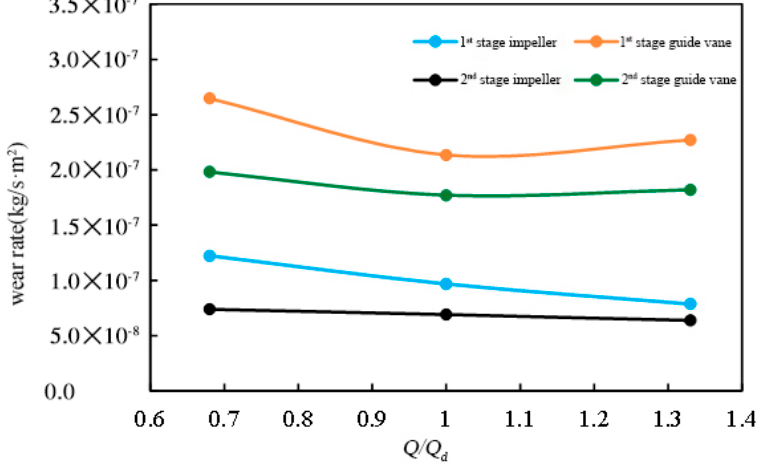
Figure 19. Change of the wear rate on the surface of the through-passage components.